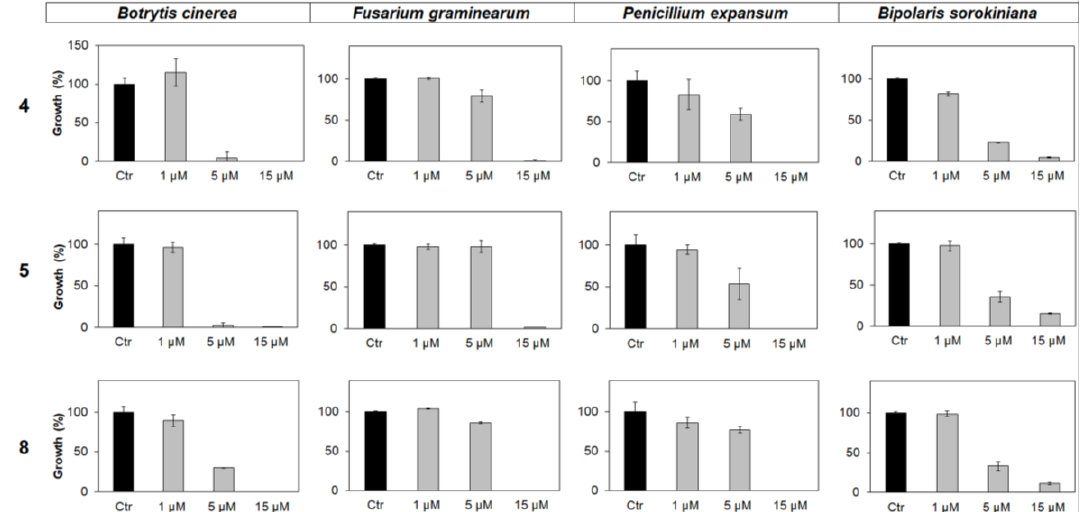
Figure 3. In vitro antimicrobial activity of 4 , 5 , and 8 against the fungal pathogens (from left to right ) B. cinerea , F. graminearum, P. expansum, and B. sorokiniana . Peptides were supplied at 1, 5, or 15 µM